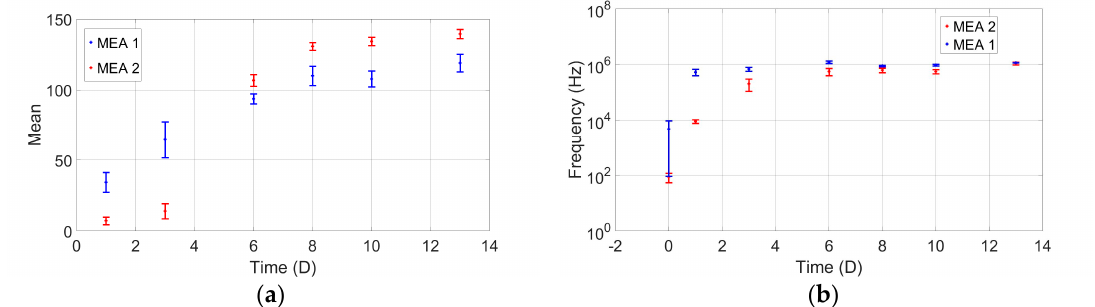
Figure 3. ( a ) Cell count over time. Dot is the mean number of all four quadrants and the error bar is the standard deviation; ( b ) Frequency of the maximum of the phase over time. Dot is the mean number of all four quadrants and the error bar is the standard deviation around the mean.